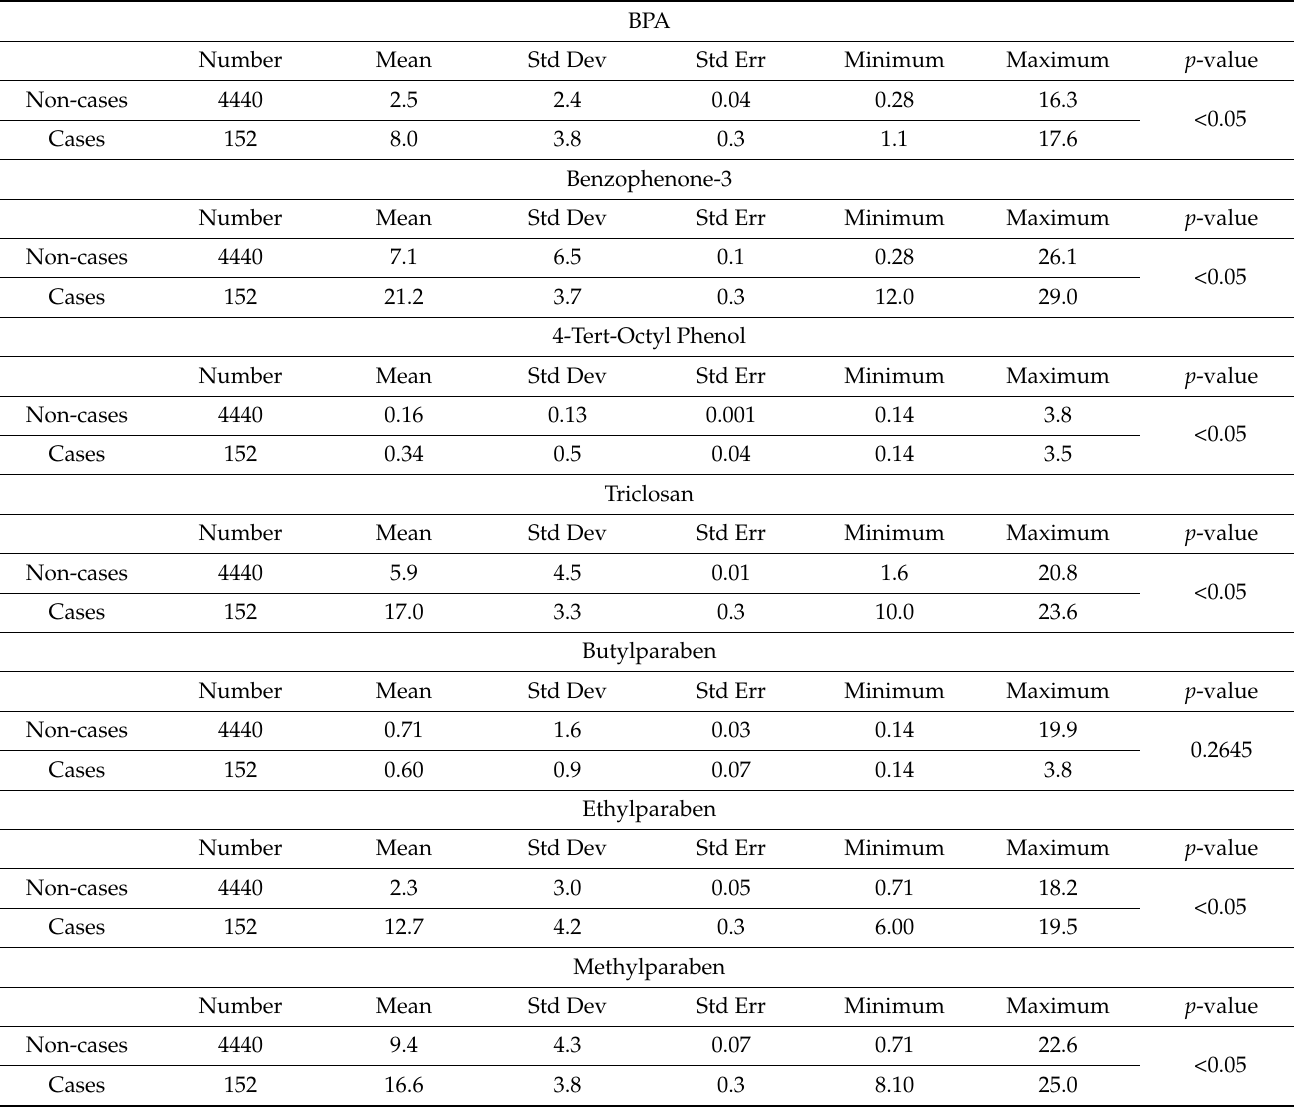
Table 3. EPs and PBs levels (ng/mL) in the urine samples of men ≥ 20 years of age with concentrations ≥ LOD; NHANES